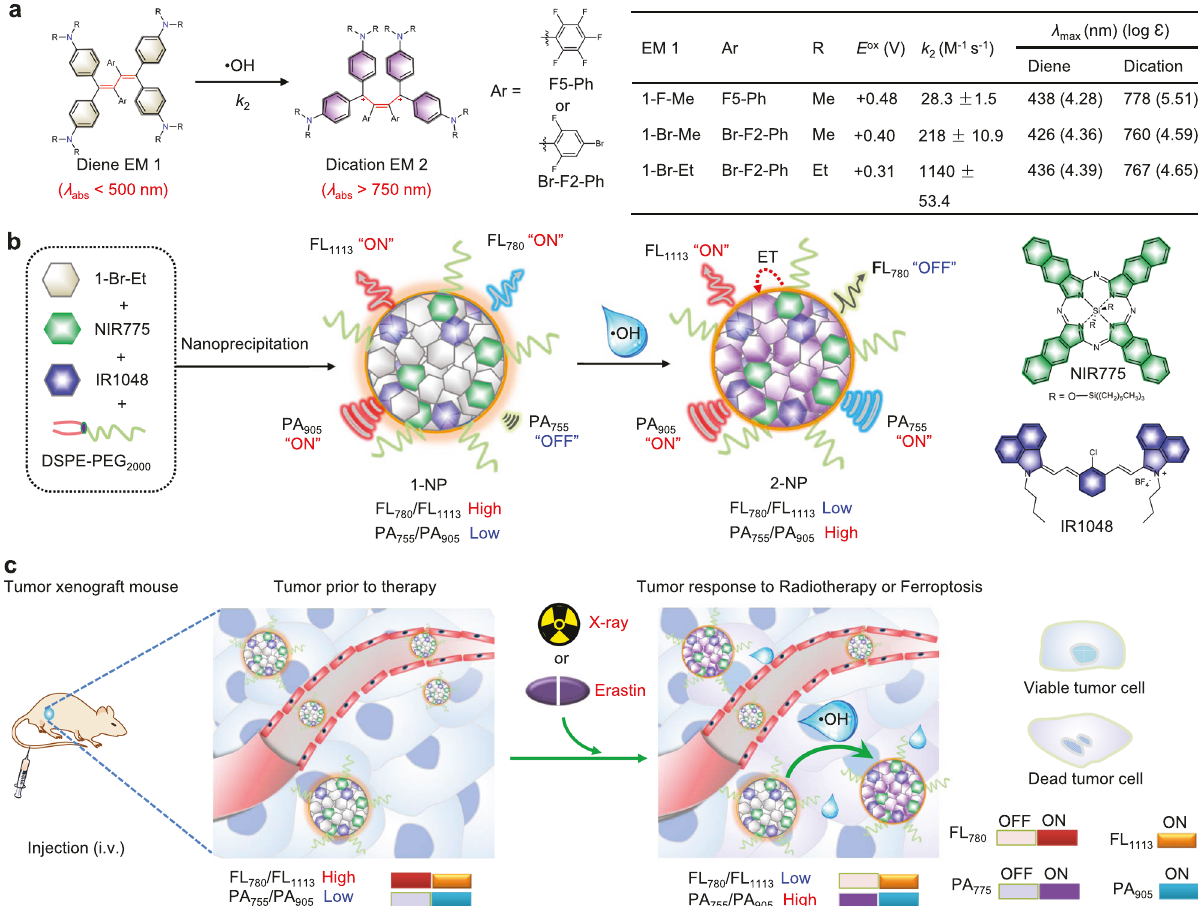
Fig. 1 Schematic illustration of the design of 1-NP. a The chemical structures of diene EM 1-F-Me, 1-Br-Me, and 1-Br-Et, and proposed conversion into dication EMs 2-F-Me, 2-Br-Me, and 2-Br-Et upon oxidation by (cid:129) OH. Right: summary of redox potentials ( E ox ), second-order reaction rate ( k 2 ), maximum absorption ( λ amx ) and extinction coef fi cient (log ε ) of EMs. b Schematic illustration of preparation of 1-NP via DSPE-PEG 2000 -assisted encapsulation of 1-Br- Et, NIR775 and IR1048, and proposed conversion of 1-NP into 2-NP in response to (cid:129) OH, accompanying by a reduced fl uorescence (FL 780 /FL 1113 ) ratio but a concurrently increased photoacoustic (PA 755 /PA 905 ) ratio. Right: chemical structures of NIR775 and IR1048 used for the preparation of 1-NP. c Illustration of the mechanism of 1-NP for ratiometric near-infrared (NIR) FL/PA bimodality imaging of (cid:129) OH production in tumors undergoing X-ray radiotherapy (RT) or erastin-induced ferroptosis. Following intravenous (i.v.) injection, 1-NP accumulates in tumor tissues via the enhanced permeability and retention (EPR) effect. In tumor cells prior to therapy with X-ray irradiation or erastin, 1-NP dominants in the tumor tissues due to the low endogenous (cid:129) OH level, and the tumors show a high FL 780 /FL 1113 but a low PA 755 /PA 905 ; in tumor cells response to the applied therapy, the (cid:129) OH level is elevated, which triggers the conversion of 1-NP into 2-NP, resulting in a low FL 780 /FL 1113 but a high PA 755 /PA 905